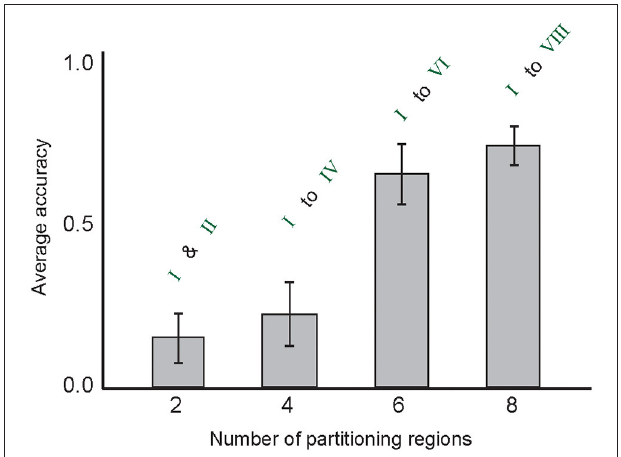
FIGURE 8 | The average classification accuracy of the model on the MNIST test data for the incremental number of used partitioning regions for image representation (from I to VIII). In the experiments, other parameter values were used. The number of selected training samples per digit class was set to 10.